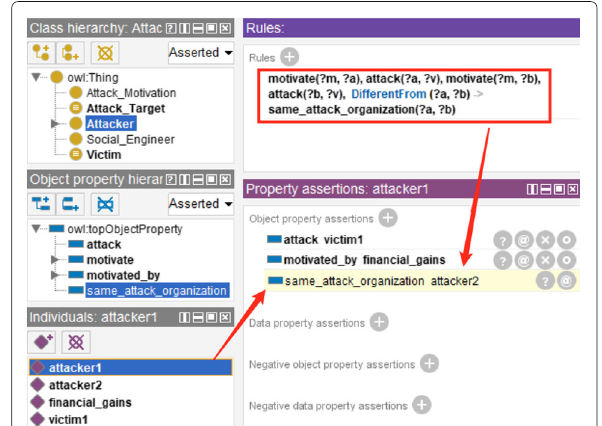
Fig. 3 Edit relations, relation description and characteristic